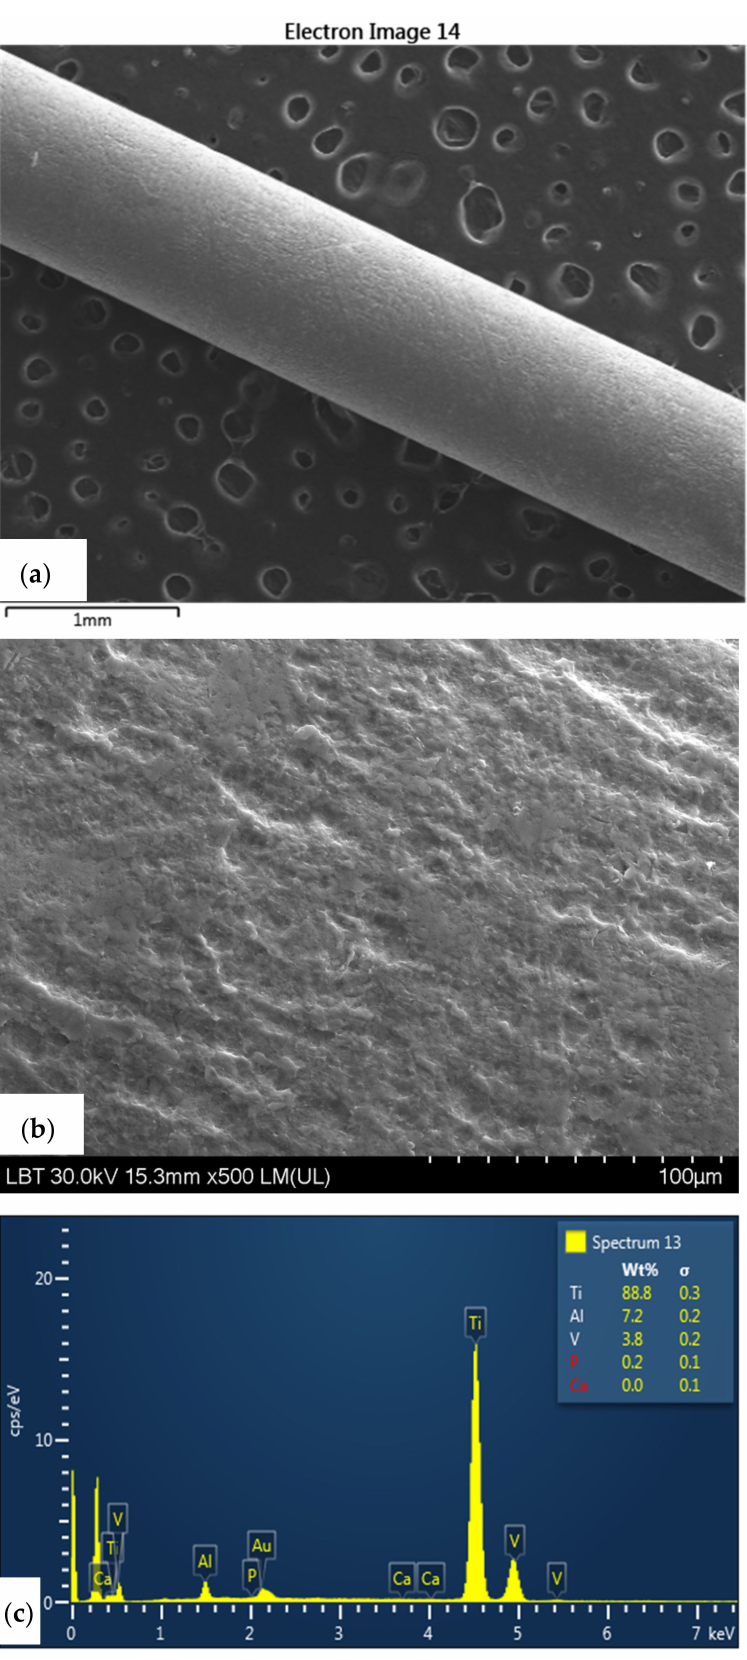
Figure 10. ( a , b ) Scanning electron microscopy image at different image magnification; ( c ) EDX analysis